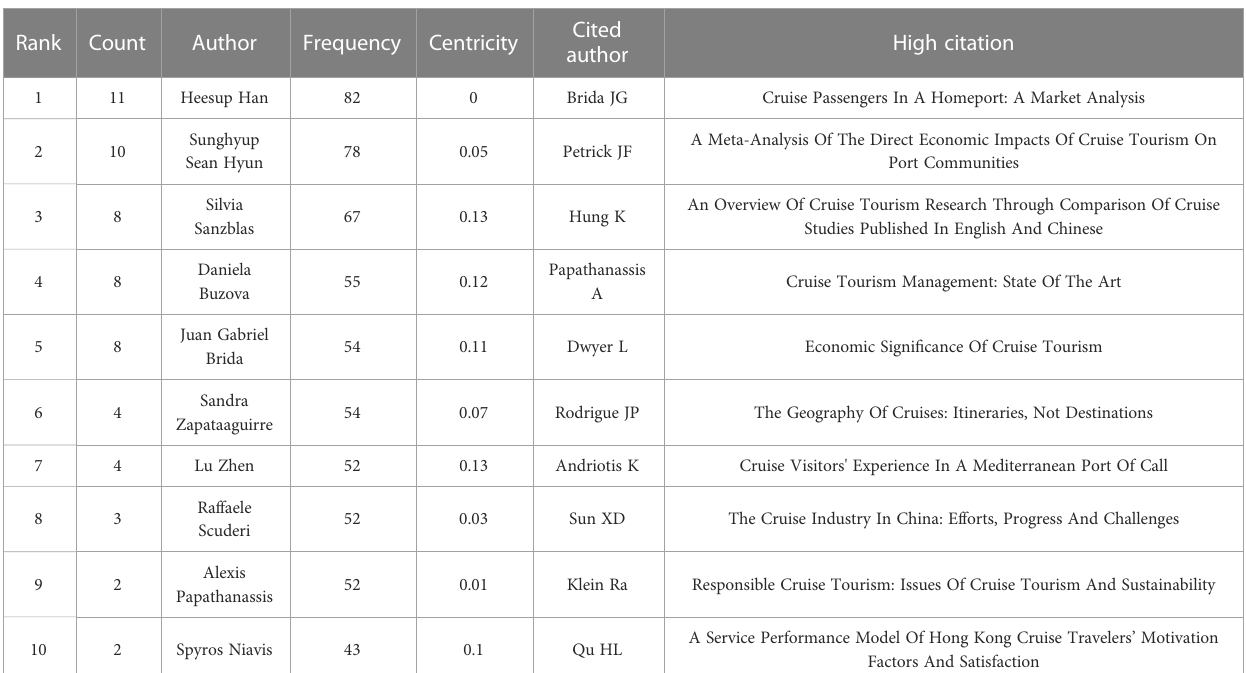
FIGURE 4 Visualization of authors in cruise research: (A) Collaborative network of lead authors in cruise research; (B) Cited authors in cruise research.